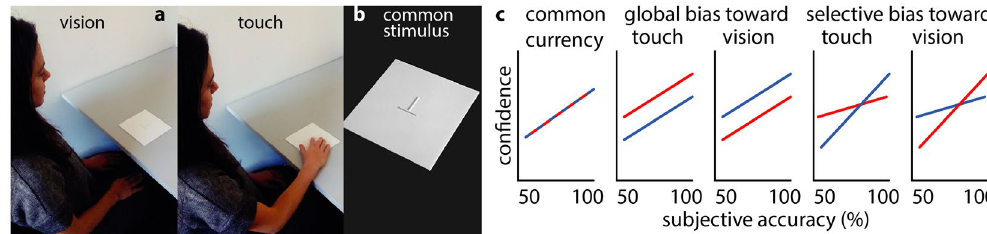
Figure 2. Stimuli and hypotheses ( a ) Testing conditions. ( b ) Stimulus designed to be clearly seen and felt. Hypothetical confidence profiles as a function of the difference from the PSE. ( c ) Possible confidence profiles: Common currency, global overconfidence in touch, global overconfidence in vision, greater confidence in touch under ambiguity, greater confidence in vision under